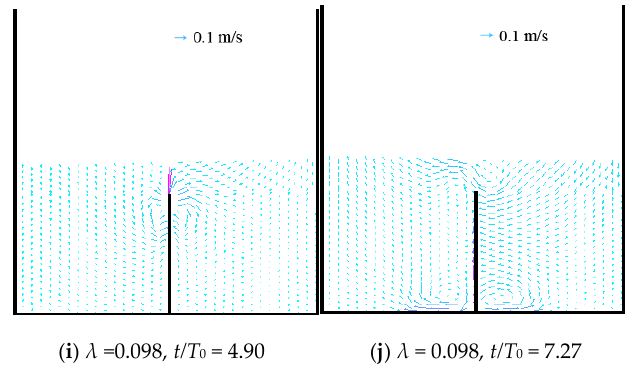
Figure 19. The fluid velocity fields of sloshing in the tank without a baffle, with an impermeable baffle, and with a permeable baffle at different time instants. ( a ) Non-baffle, t/T 0 = 4.90; ( b ) Non-baffle, t/T 0 = 7.27; ( c ) Impermeable baffle, t/T 0 = 4.90; ( d ) Impermeable baffle, t/T 0 =7.27; ( e ) λ = 9.8 × 10 − 6 , t/T 0 = 4.90; ( f ) λ = 9.8 × 10 − 6 , t/T 0 = 7.27; ( g ) λ = 2.43 × 10 − 5 , t/T 0 = 4.90; ( h ) λ = 2.43 × 10 − 5 , t/T 0 = 7.27; ( i ) λ =0.098, t/T 0 = 4.90; ( j ) λ = 0.098, t/T 0 = 7.27. (unit of λ is m/s).